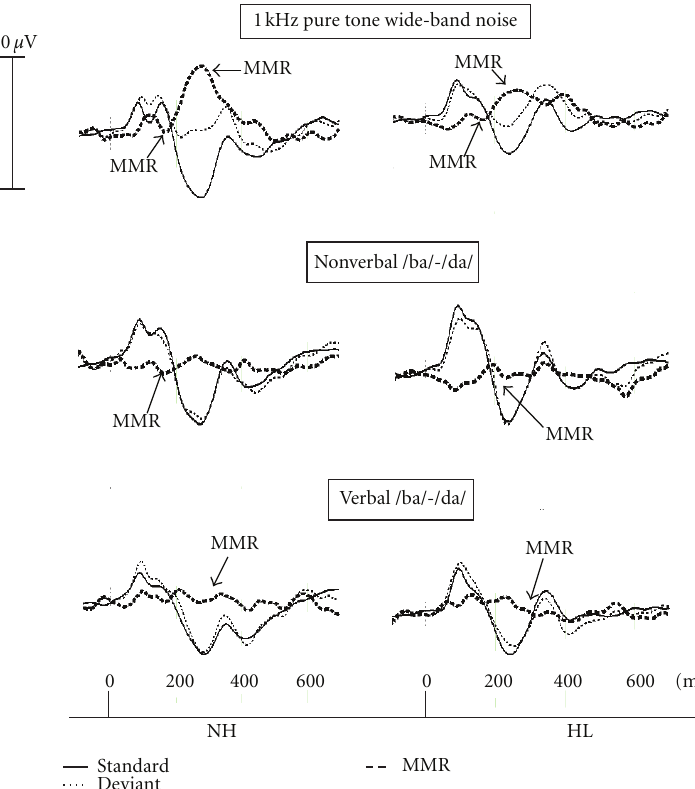
Figure 4: The grand average ERPs of five children with normal hearing (NH) and the five children with hearing loss (HL), elicited by the standard stimuli (solid lines): 1kHz pure tone (top), nonverbal /ba/ (middle), and /ba/ (bottom); by the deviant stimuli (dotted lines): wide-band noise (top), nonverbal /da/ (middle), and /da/ (bottom). The mismatch response (MMR) is represented by a bold dashed